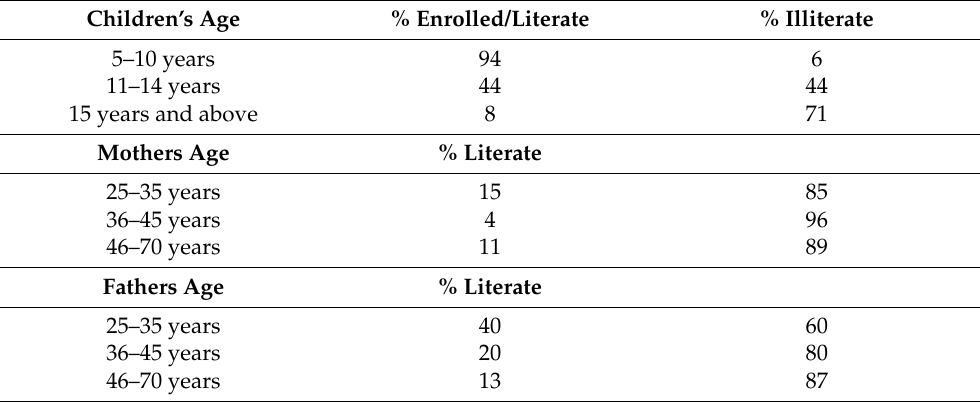
Table 4. Parental literacy and child